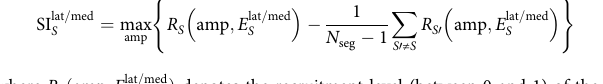
Supplementary Table 2. During the surgical procedures, the monkeys were implanted with bipolar stainless-steel electrodes to record electromyographic signals (sampling rate = 24 kHz) from the following upper-limb muscles: deltoid (DEL), biceps brachii (BIC), triceps brachii (TRI), fl exor carpi radialis (FCR), fl exor digitorum super fi cialis (FDS), extensor carpi radialis (ECR), extensor digitorum communis (EDC), and abductor pollicis brevis (APB). In one monkey (Mk-Ca), the fl exor carpi ulnaris (FCU) and extensor carpi ulnaris (ECU) were recorded in place of FCR and